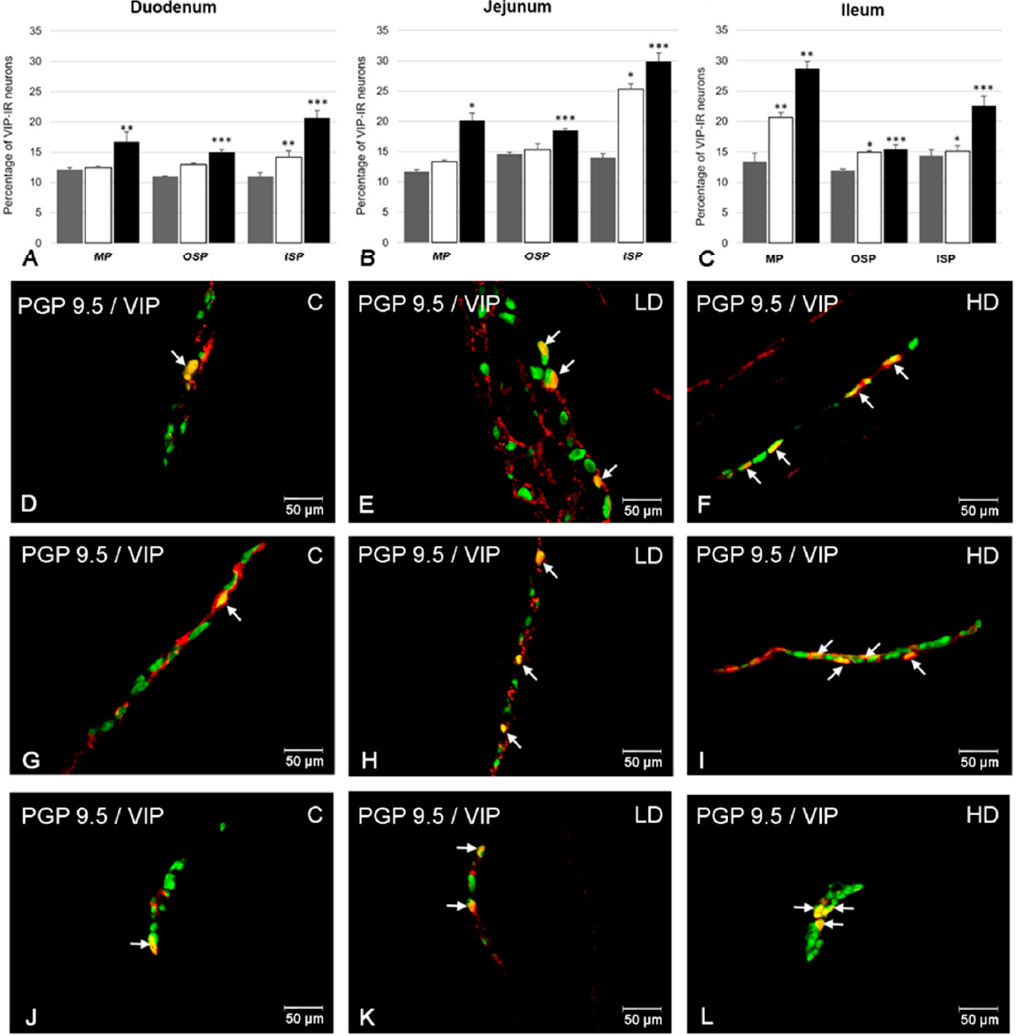
Figure 1. The number of vasoactive intestinal peptide-like immunoreactive (VIP-LI) neurons in the myenteric plexus (MP), outer submucous plexus (OSP), and inner submucous plexus (ISP) in each part of the porcine small intestine (duodenum, jejunum, and ileum) in all experimental groups ( A – C ) and the most representative images showing neurons immunoreactive to protein gene-product 9.5